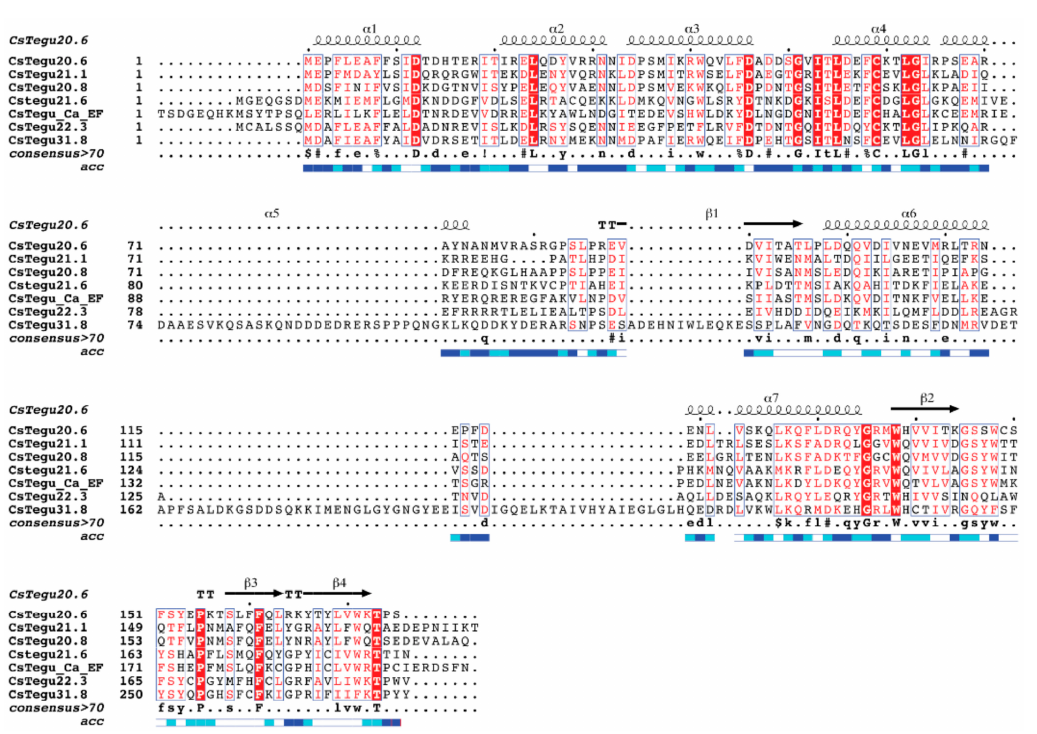
Figure 1. Comparison of amino acid sequence of the 20.6-kDa tegumental protein of C. sinensis (CsTegu20.6) with other C. sinensis tegumental proteins. Multiple sequences alignment was visualized by ESPript [21] after alignment of the protein sequences using MAFFT [22]. Secondary structure features of CsTegu20.6 are given above the alignments. α -helices and β -strands are represented as helices and arrows, respectively, and β -turns are marked with TT. Conserved areas are shown shaded. Conserved sequences are indicated by a box if more than 70% of the residues are similar. The similar sequences are indicated by colored background considering physico-chemical properties. “acc” indicates the relative accessibility of each residue. The blue square scale is set as follows: “accessible” ( blue , 0.4 < A ≤ 1.0), “intermediate” ( cyan , 0.1 ≤ A ≤ 0.4) and “buried” ( white , A < 0.1). Accession numbers of the sequences presented are as follows: CsTegu21.1 (ADZ13689.1), CsTegu20.8 (ABC47326.1), CsTegu21.6 (JF911532), CsTegu_Ca (ABZ82044), CsTegu22.3 (ABK60085.1) and CsTegu31.8 (ABK60086.1).